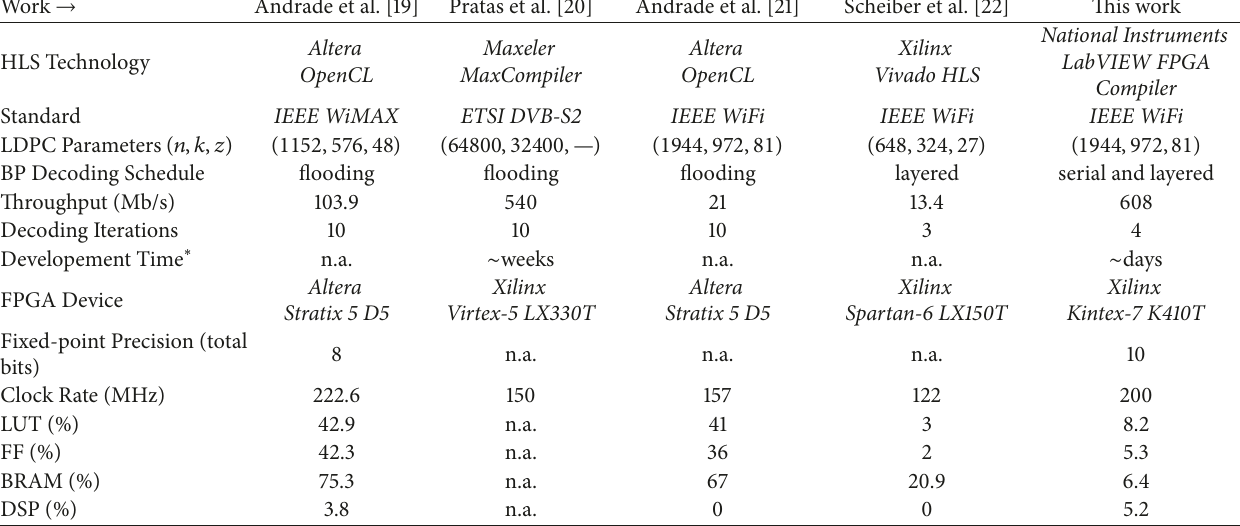
Table 10: Comparative survey of the state-of-the-art. Note that, while there are multiple implementation case studies in [19, 21], we only list here those cases which are the closest in terms of the QC-LDPC code used in our case study, namely the IEEE 802.11n (WiFi) (1944, 972) QC-LDPC code with 𝑧 = 81 . ∗ Development time (wherever reported) quantifies the programming effort required. This measure of the programming effort has been defined in [20] and is adopted here to facilitate an unambiguous comparison. In our work, the development effort is of the order of a few days of programming effort, once the algorithm to be implemented is finalized; including the total compile time which is of the order of tens of